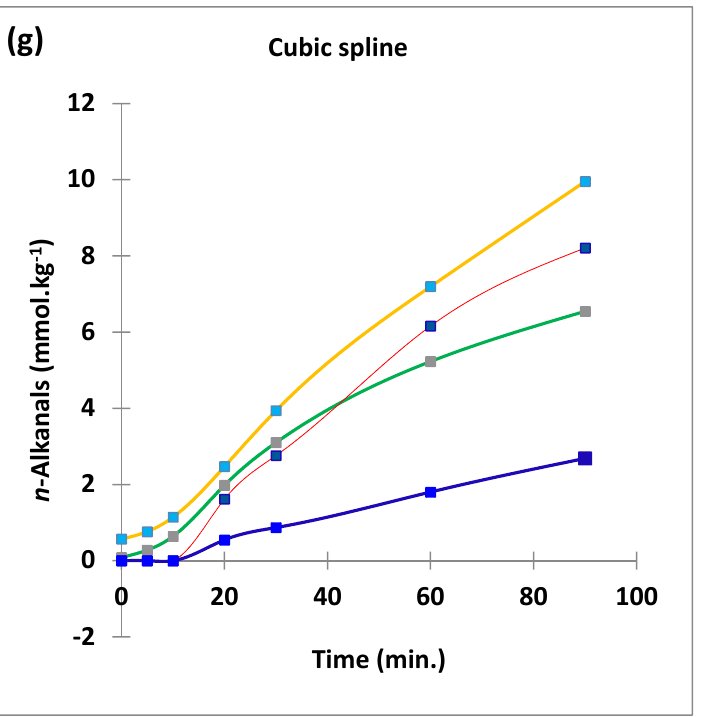
Figure 2. Boxplots of median±95% confidence intervals (CIs) levels of 1 H NMR-determined trans -2-alkenals, alka-( trans,trans )-2,4-dienals and n -alkanals generated in ( a ) sunflower, ( b ) extra-virgin olive, ( c ) canola and ( d ) coconut oils at 0, 5, 10, 20, 30, 60 and 90 min. time-points of exposure to LSSFEs at a temperature of 180 °C. The notch depicts the median CIs, and the mean concentrations of each group are indicated by yellow diamonds. Abscissa and ordinate axes are heating time-points and aldehyde concentrations (mmol.kg − 1 ), respectively. ( e , f , g ), Corresponding cubic spline polynomial plots of mean total 1 H NMR-determined trans -2-alkenal, alka-( trans,trans )-2,4-dienal and n -alkanal concentrations, respectively, as a function of heating time for coconut (blue), canola (red), extra-virgin olive (green) and sunflower (yellow curve) oils. The cubic spline analyses performed on our time-dependent aldehyde concentration datasets involved a piecewise func- tion of third-degree polynomials; computation of the cubic spline coefficients featured polynomial derivatives [54]. Results from univariate statistical analysis performed by an ANOVA model (equation 1) for the ‘between-oils’, ‘between-time- points’ and oils x time-points interaction effects were p = 2.49 × 10 − 44 , 1.09 × 10 − 82 and 1.17 × 10 − 38 , respectively for trans -2- alkenals; p = 5.98 × 10 − 50 , 1.39 × 10 − 74 and 2.23 × 10 − 41 , respectively for alka- trans,trans- 2,4-dienals; and p = 5.10 × 10 − 28 , 1.15 × 10 − 64 and 1.04 × 10 − 16 , respectively for n -alkanals. The highly significant interaction effects observed for all aldehydes indi- cate the differential time dependencies of their concentrations generated for each oil investigated.